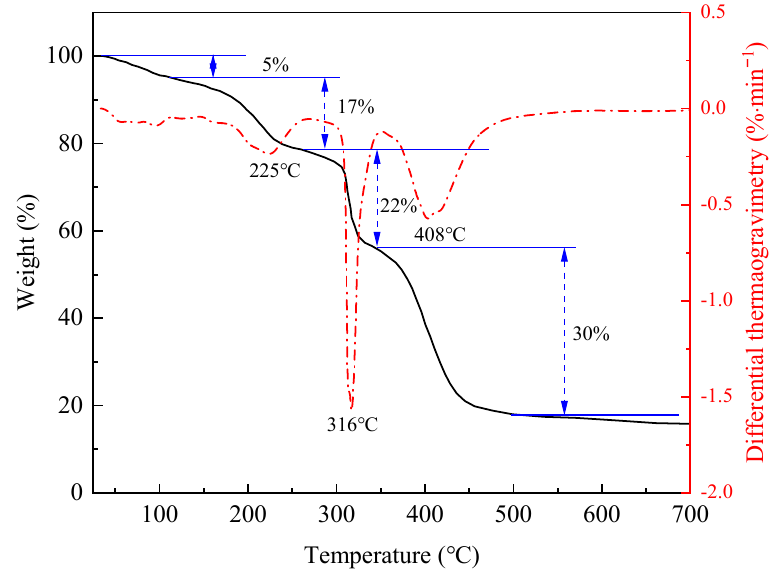
Figure 7. Thermogravimetric analysis of polymeric microspheres.